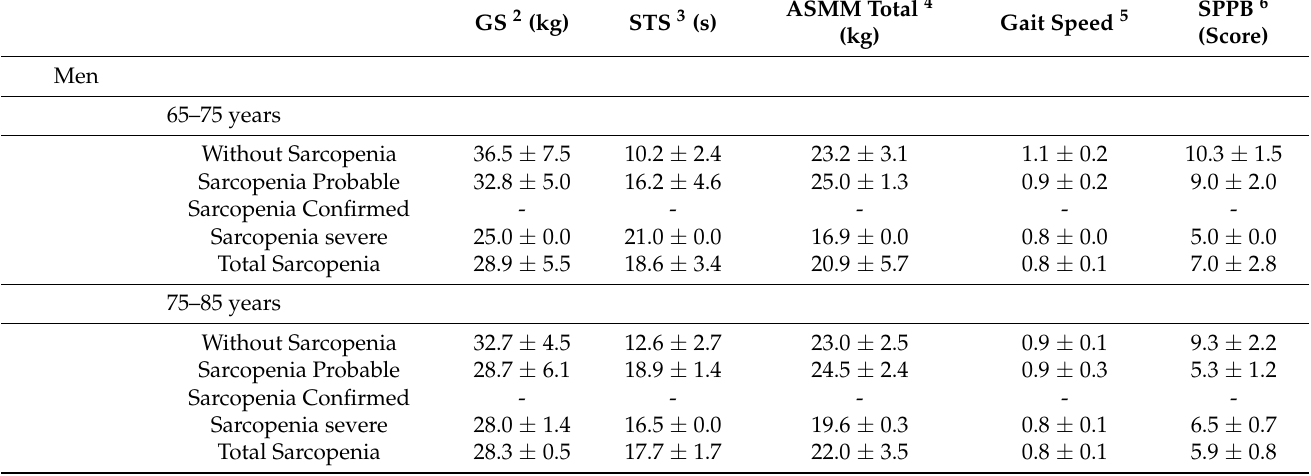
Table 2. Mean values 1 of the different tests to assess sarcopenia subdivided by sex, age, and sarcopenic